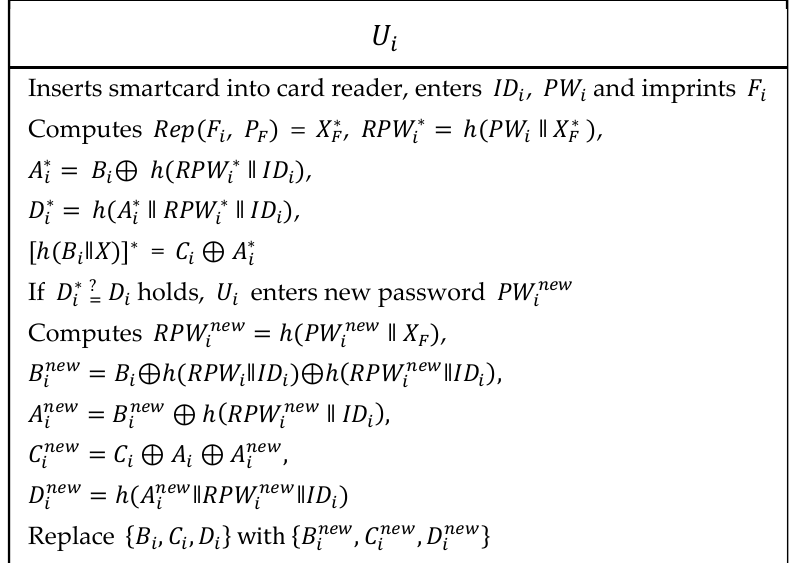
Figure 4. Password update phase of Ali et al.’s scheme.